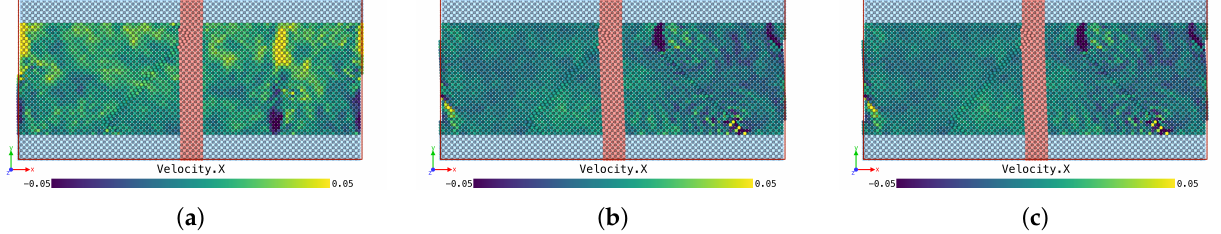
Figure 17. Illustration of set of particles tracked during the oscillatory test in a viscoelastic substance modelled with (cid:101) CS = 1 × 10 − 5 and µ = 0.1. Particles coloured by velocity in x − direction, at three different time instants. ( a ) t = 2.0 s. ( b ) t = 2.35 s. ( c ) t = 2.6